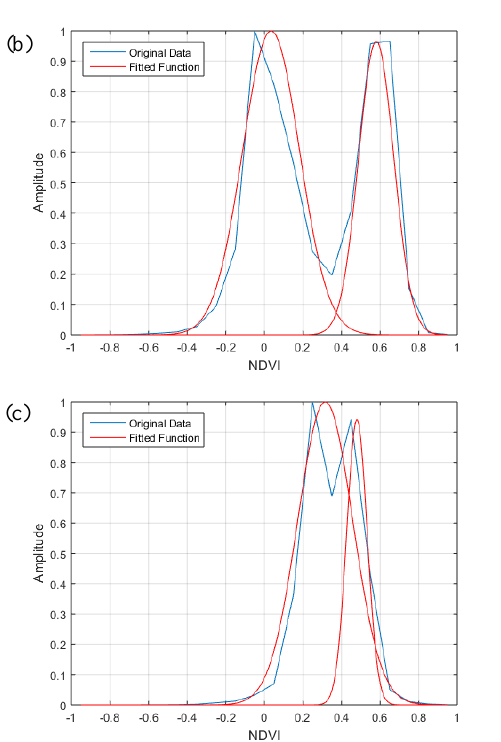
Figure 6. Gaussian decomposition of the ground NDVIs’ histograms; a) NDVI C2-C1 , b) NDVI C2-C3 , and c) NDVI C1-C3